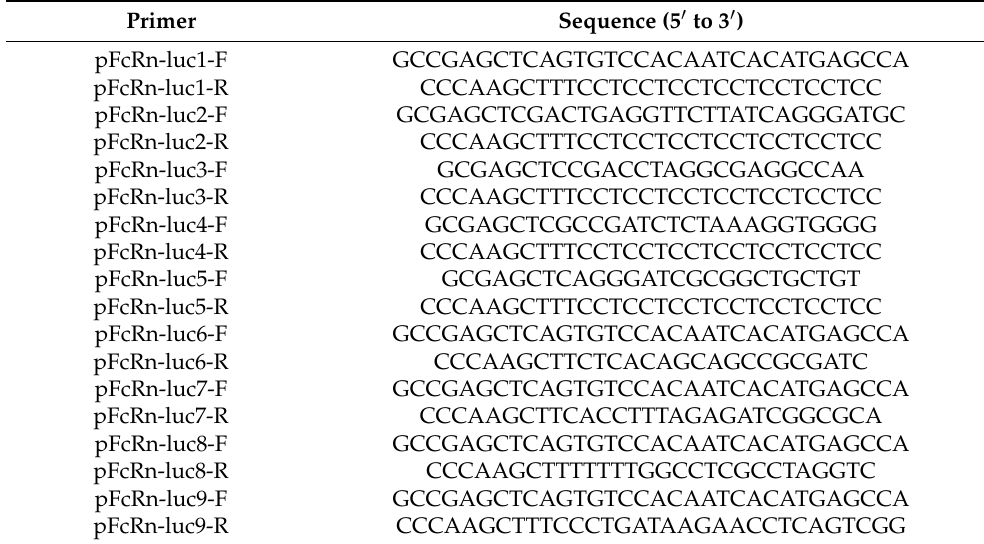
Table 1. Primers used for cloning of pFcRn gene promoter. Primer Sequence (5 (cid:48) to 3 (cid:48)